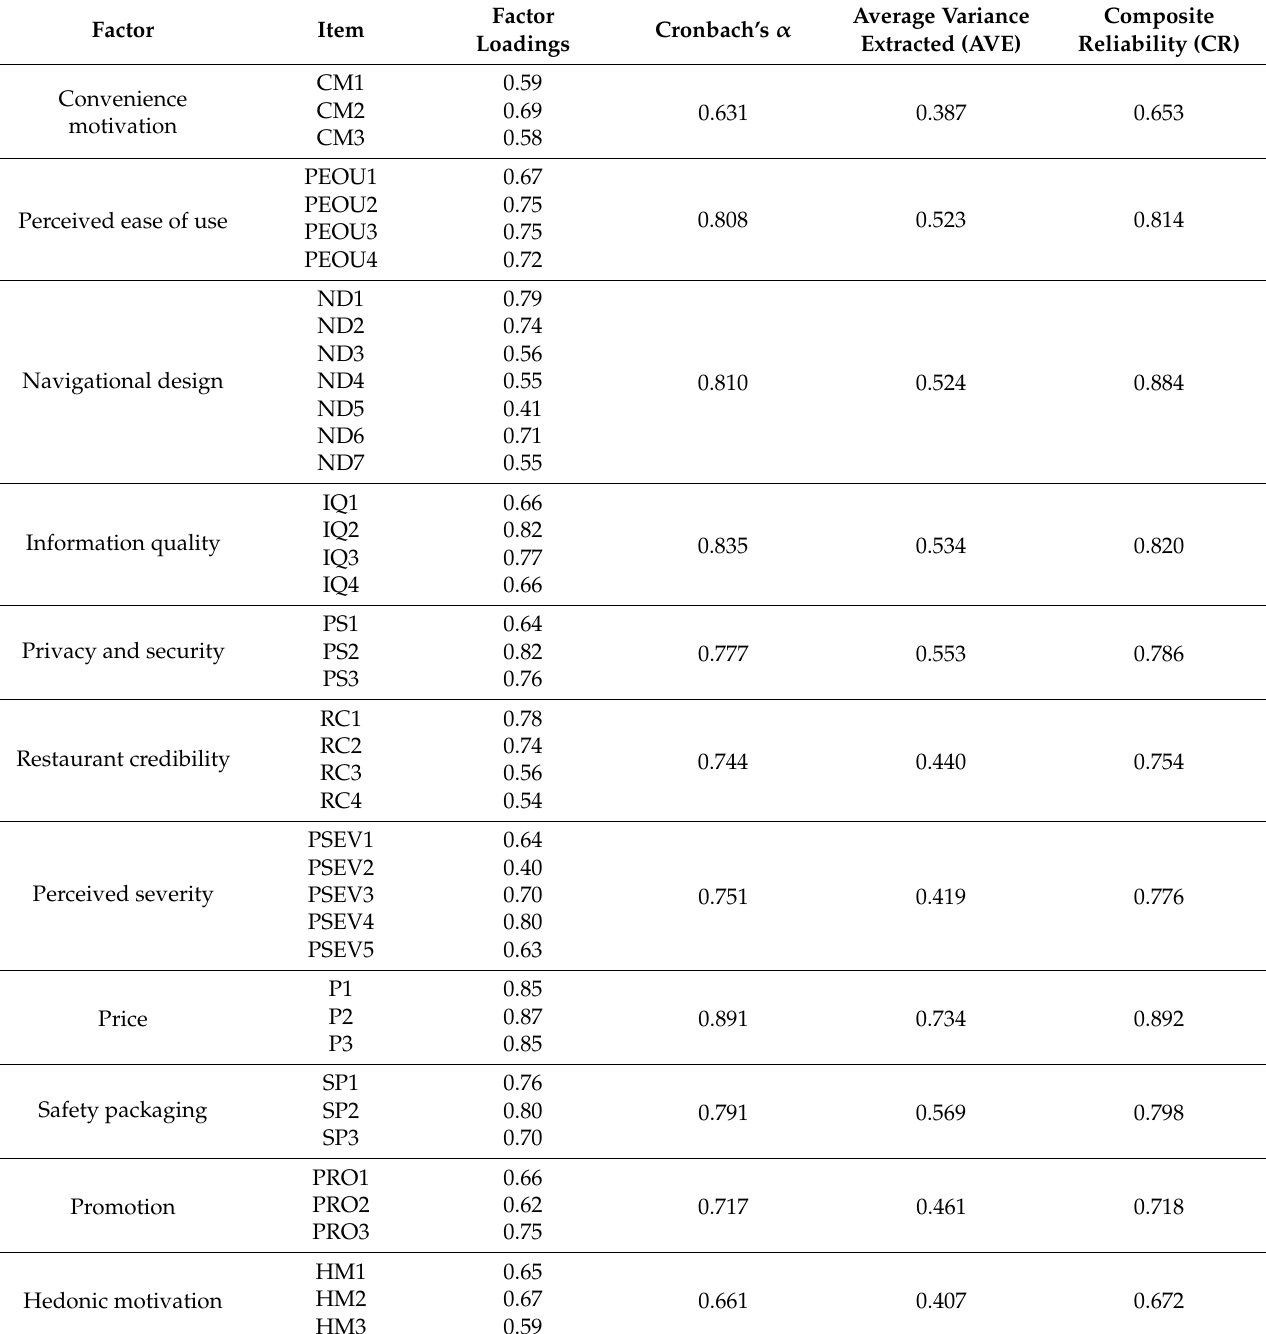
Table 3. Factor Loadings, validity, and